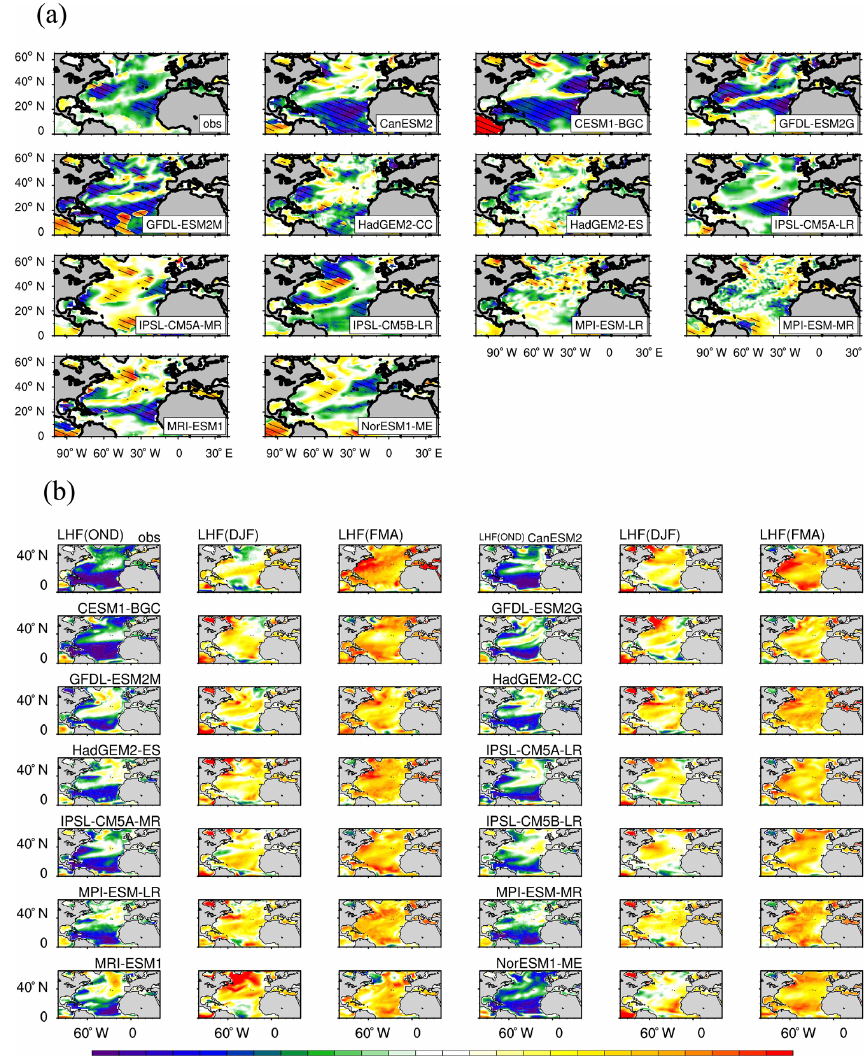
Figure 9. Same as Fig. 8 but for the